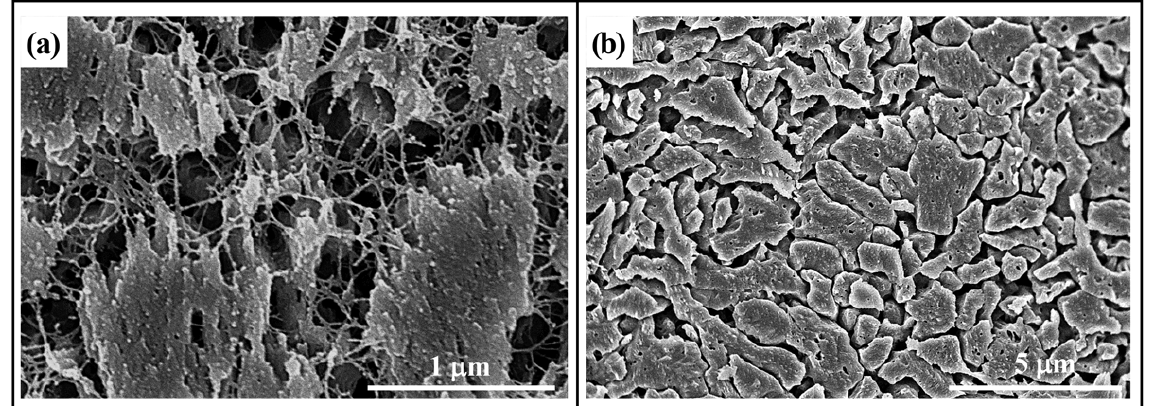
Figure A8. Pristine (a) and hydrothermally altered (b) shell portion of Arctica islandica . Alteration occurred in burial fluid at 175 ◦ C and lasted for 7 days. Well visible in (a) is the network of biopolymer fibrils between and within pristine aragonite nanoparticles and mineral units. This is destroyed at alteration and numerous voids (b) become visible within the mineral